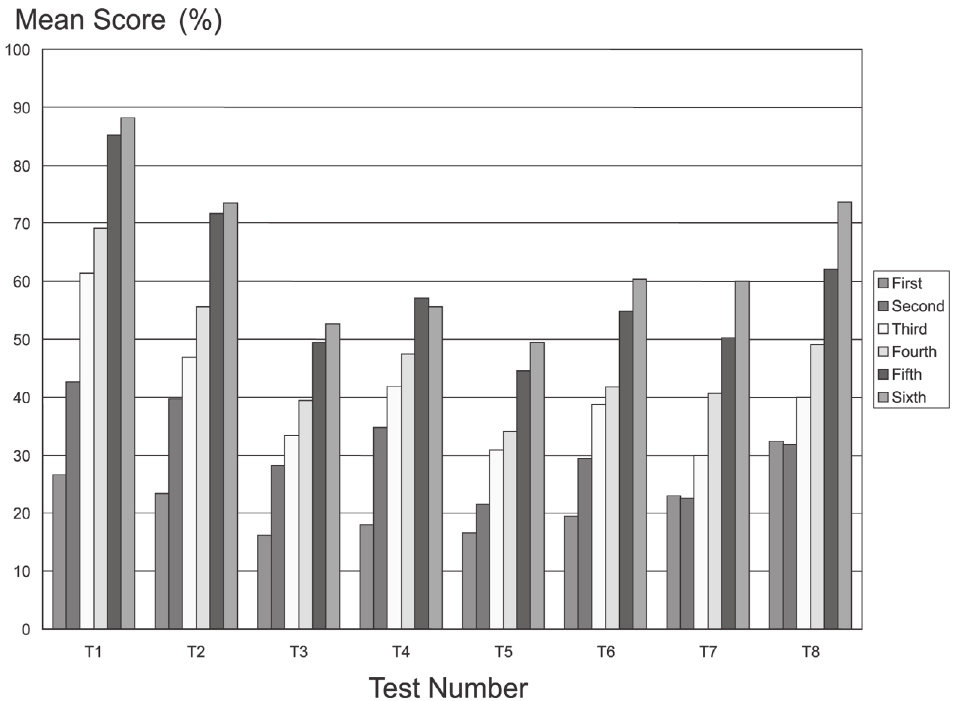
Figure 4 - Mean scores (%) for clerkship rotation questions, for students from first to sixth year, according to occasion on which the test was applied (tests 1-8). (For all tests, P < .0001). *For each sequence of columns, the first represents first-year students; the second, second-year students; the third, third-year students; the fourth, fourth-year students; the fifth, fifth-year students; and the sixth, sixth-year